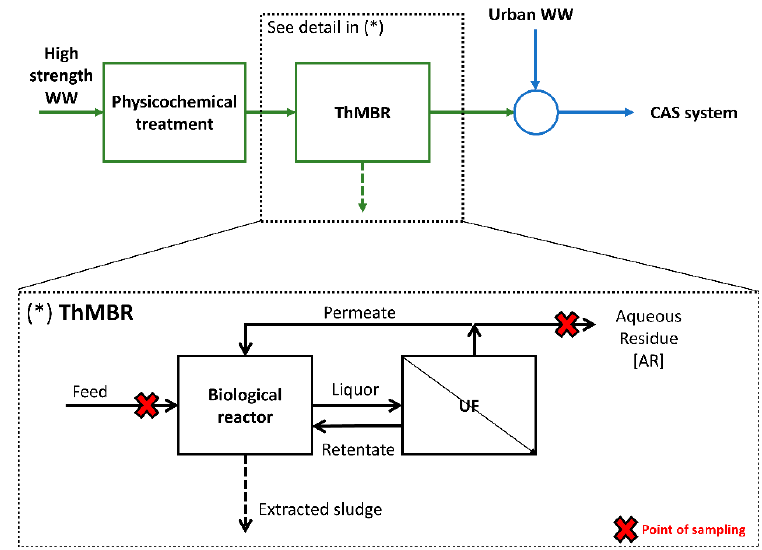
Figure 1. Localization and details of ThMBR in the pretreatment line for high-strength WW.